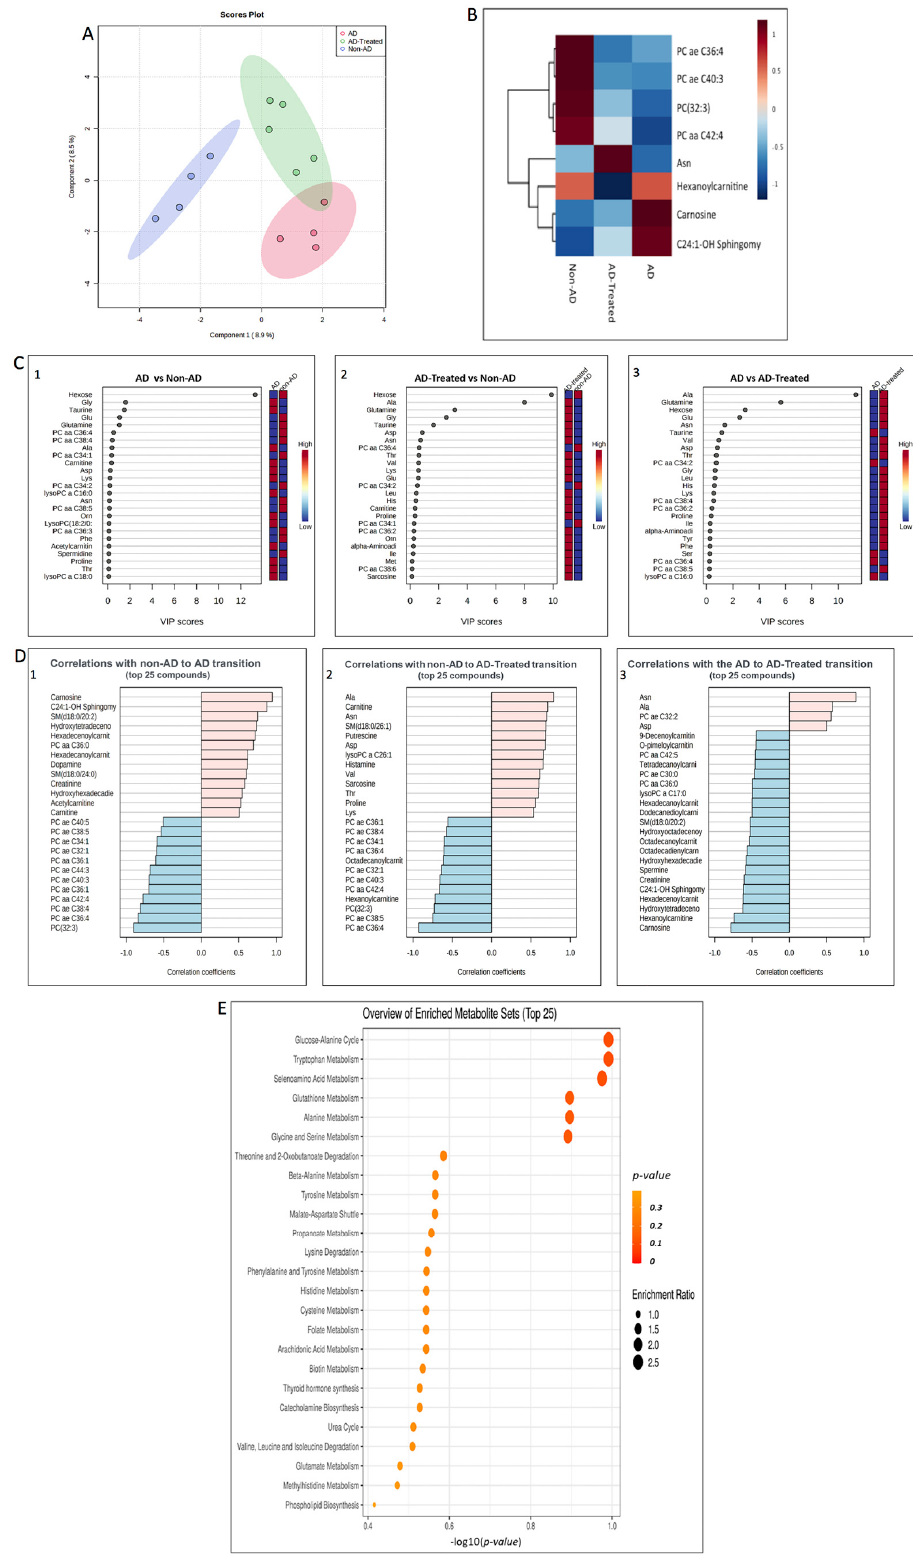
Figure 9. Metabolomics analysis of the liver. ( A ) PLS-DA (“supervised PCA”) obtained from the three groups (non-AD, AD mice, and treated AD mice) showed separation of the samples, with the AD mice and the non-AD mice showing the biggest difference, while the treated AD group